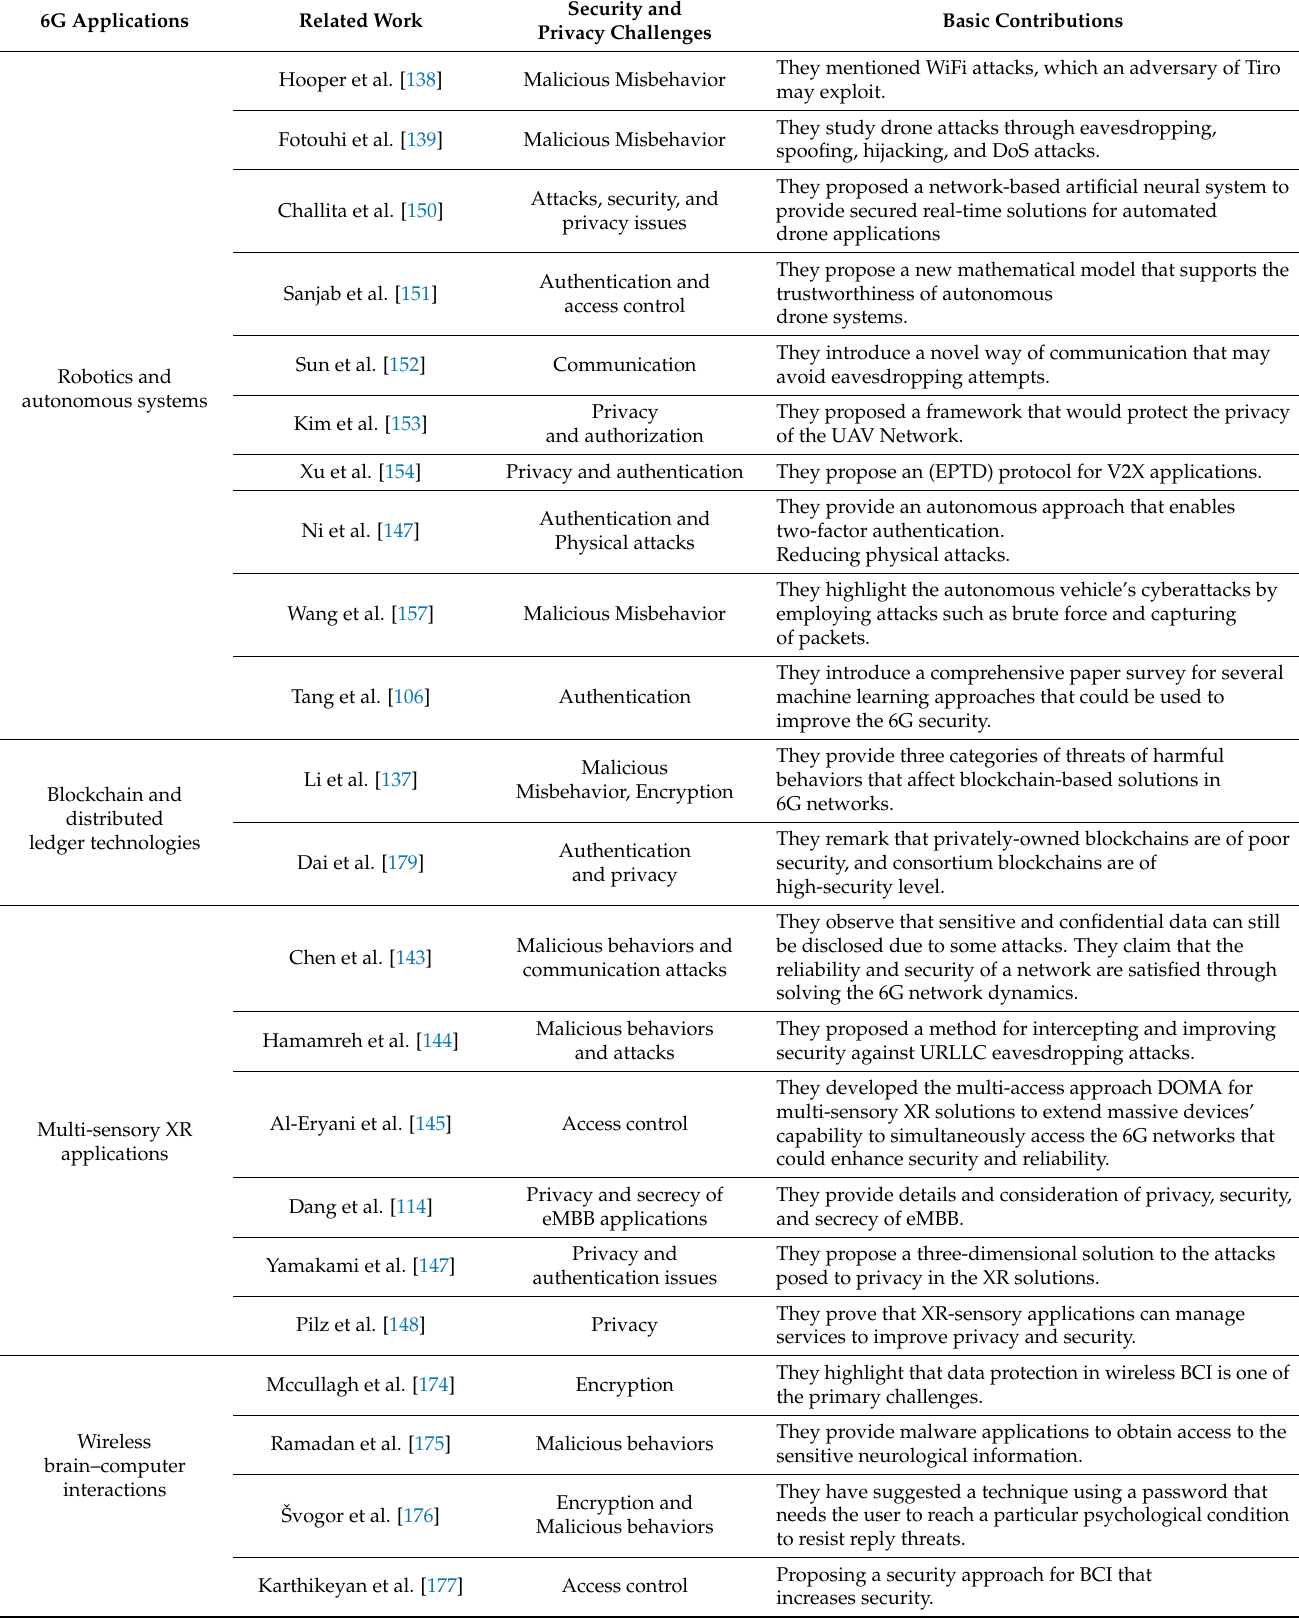
Table 5. The security and privacy challenges of 6G application-related work and their